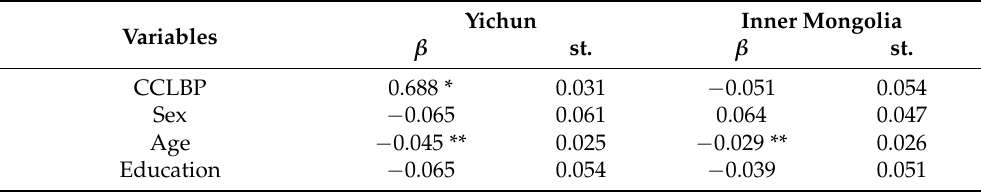
Table 10. Regression results of life satisfaction in different forest groups. Yichun Inner Variables